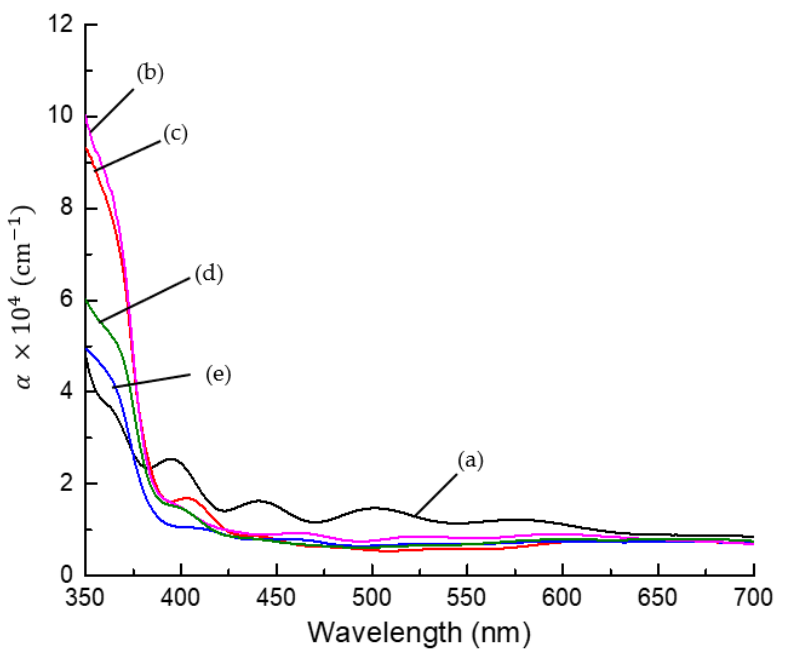
Figure 6. Change of α with λ for ( a ) the n-TiO 2 /FTO substrate and the n-TiO 2 /ZnO bilayer thin films annealed for ( b ) 1, ( c ) 1.5, ( d ) 2, and ( e ) 2.5 h at 500 °C, respectively.